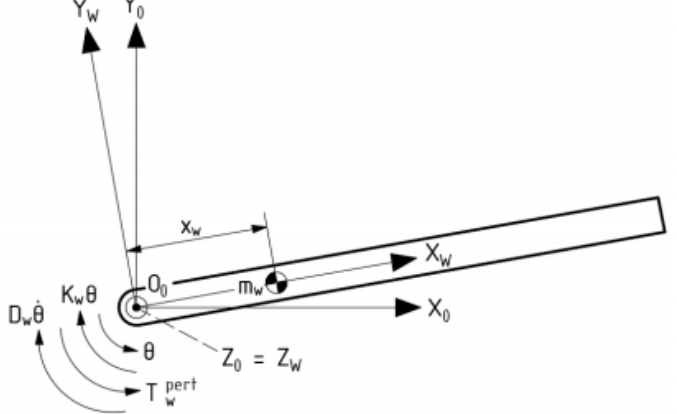
(cid:0) . (cid:1) p where is relative speed, which has zero value since x W , y W , z W are fixed. w relative